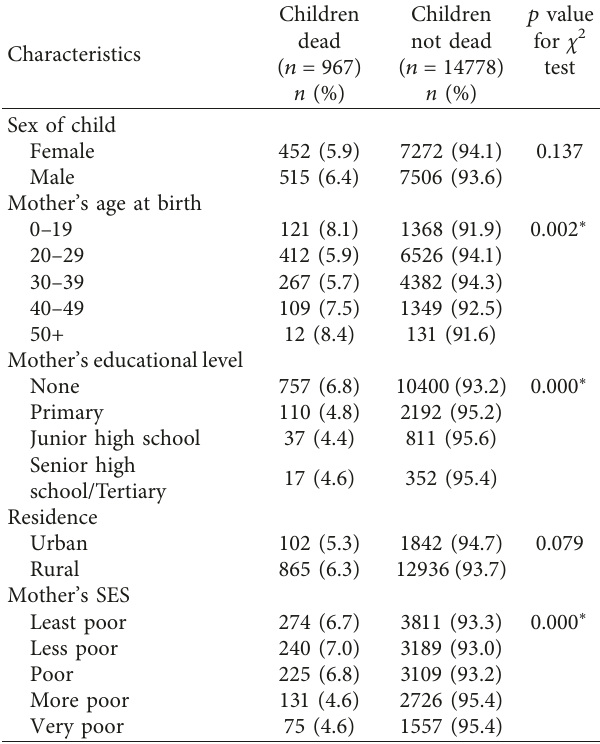
Table 3: Bivariate analysis of risk factors and child mortality ( N �